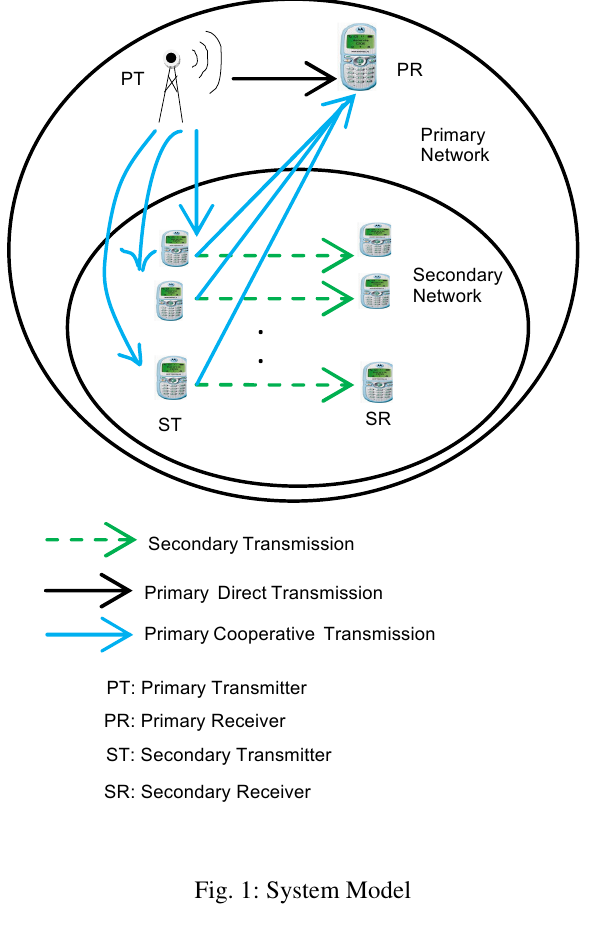
Fig. 1: System Model